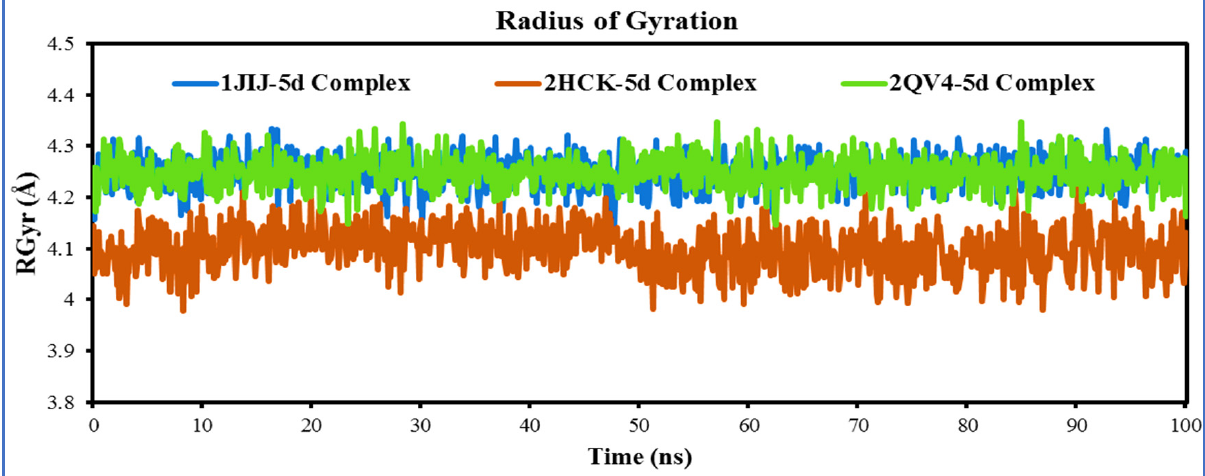
Figure 7. Time dependent radius of gyration (RGyr) plot of 1JIJ-5d complex (blue), 2HCK-5d complex (red) and 2QV4-5d complex (green) obtained from 100 ns MD simulation trajectories.